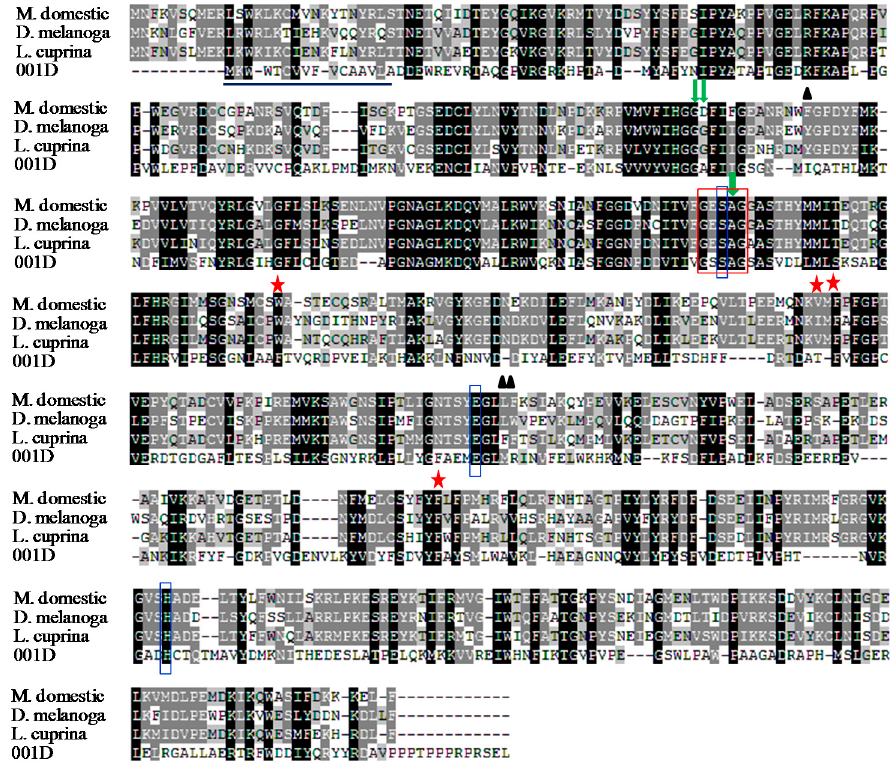
Figure 1 . Alignment of the deduced amino acid sequences of 001D (GenBank ® accession number KT345935) from the H. armigera Wuhan (WH) strain with the previously reported insect carboxylesterase E7 (GenBank ® accession number AAD29685) from Musca domestica , а E7 (GenBank ® accession number NP_524261) from Drosophila melanogaster and the E3 (GenBank ® accession number AAB67728) from L. cuprina . The signal peptide sequences of 001D are underlined, the catalytic triad residues are vertically boxed in blue color, the highly conserved pentapeptide residue are boxed with red color, dark triangles indicate the anionic site, red asterisks indicate the acyl-binding pocket, green arrows mean the oxyanion hole.